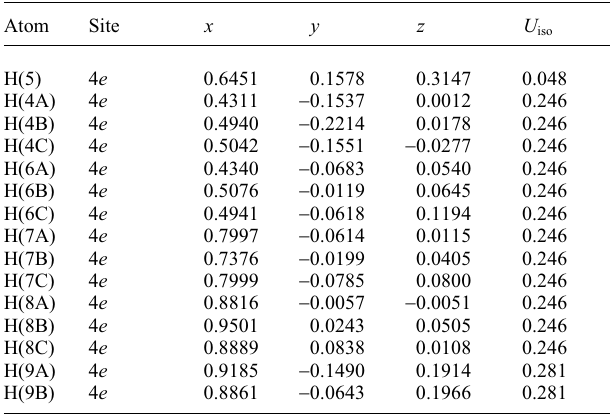
Table 2. Atomic coordinates and displacement parameters (in Å 2 )